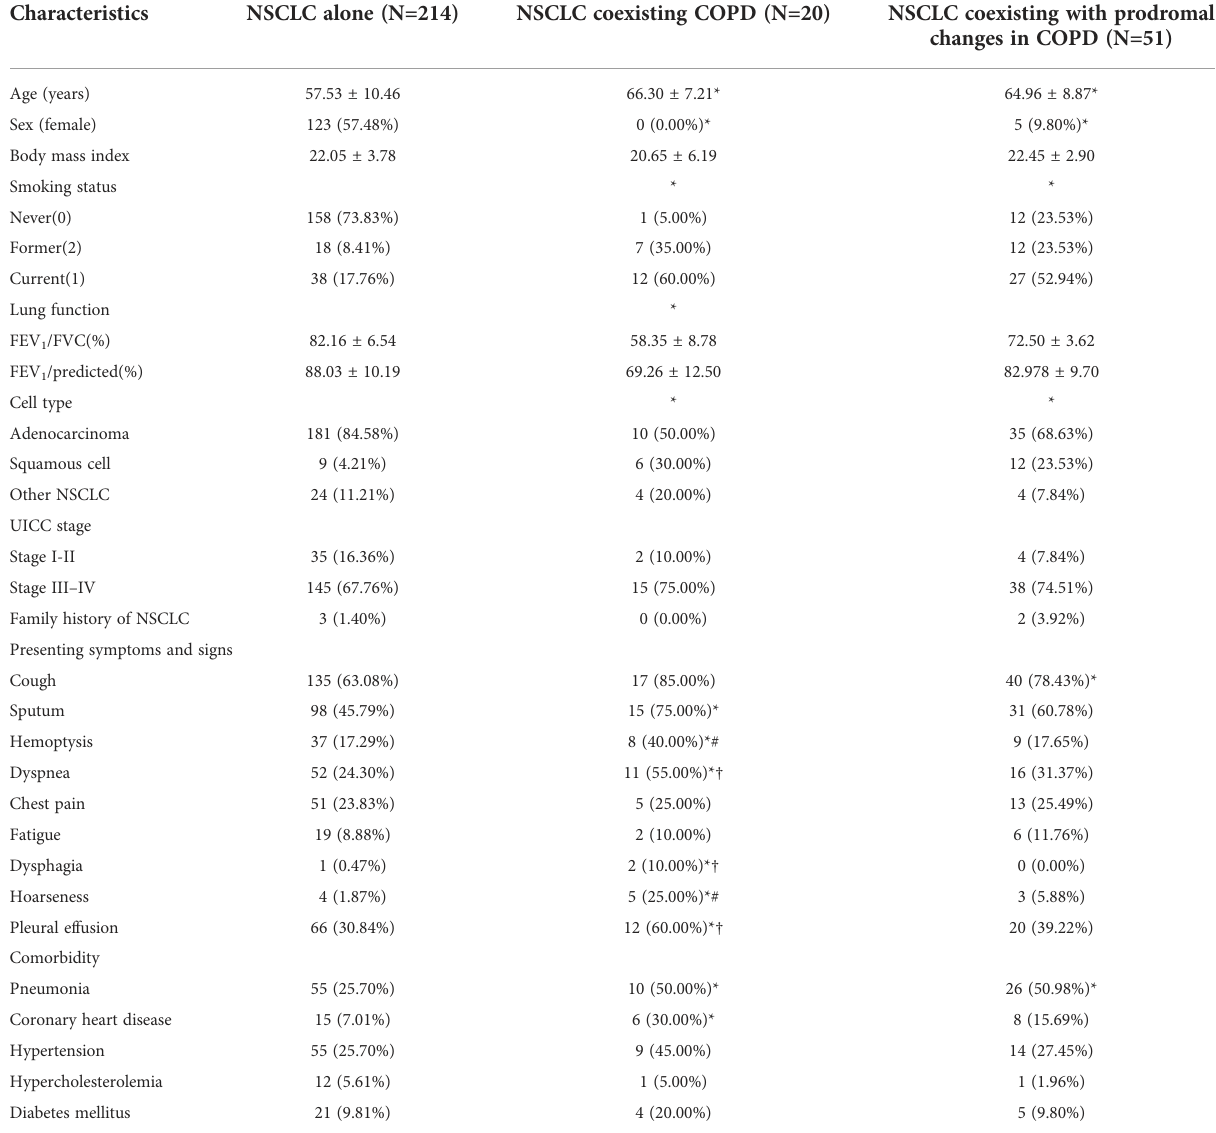
TABLE 1 Patient demographics and clinical characteristics of NSCLC cohort (N=285).